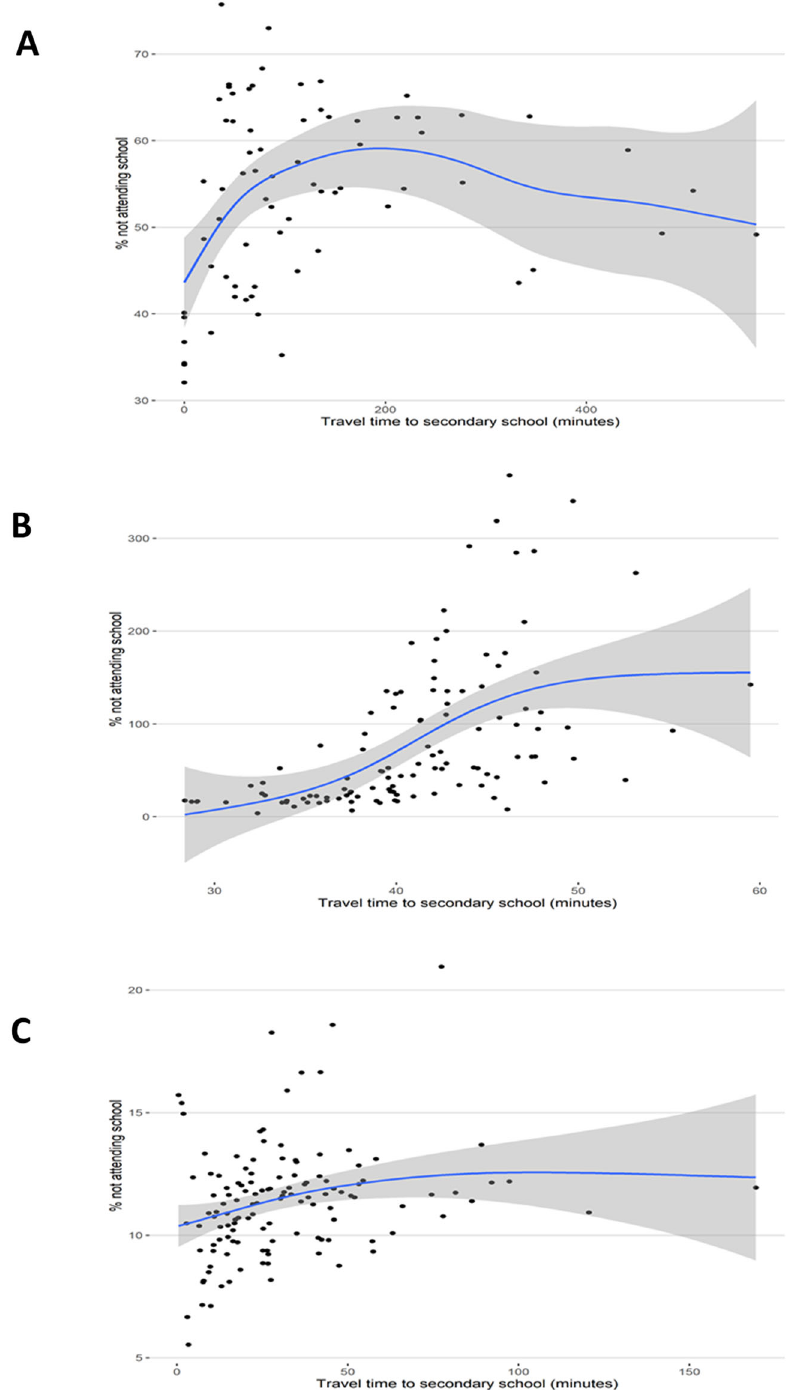
Fig. 5 Travel time and attendance. Scatter plots at the sub-national level (Administrative level 1) showing the association between mean travel time (x- axis) and the modelled posterior mean secondary school non-attendance (y-axis) for ( A ) Tanzania, ( B ) Cambodia and ( C ) the Dominican Republic. The fi tted blue line is the non-linear fi t via GAM regression with corresponding 95% CI (grey